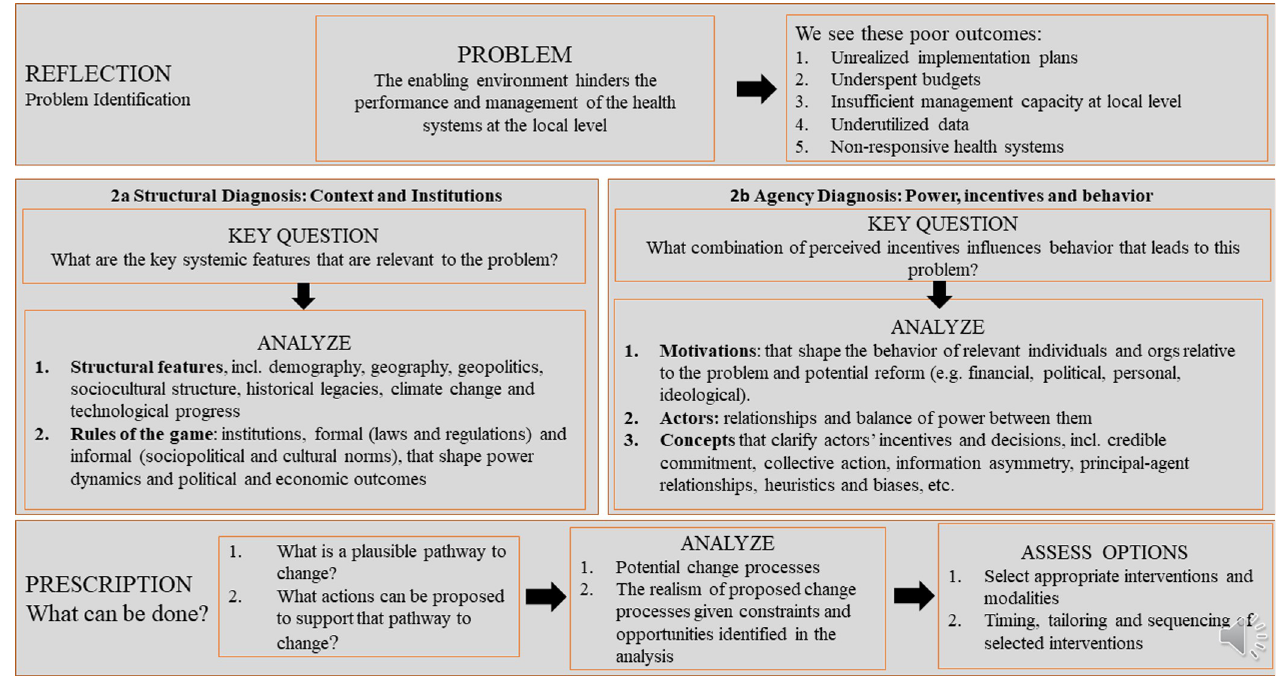
Fig 1. Problem-driven PEA theoretical